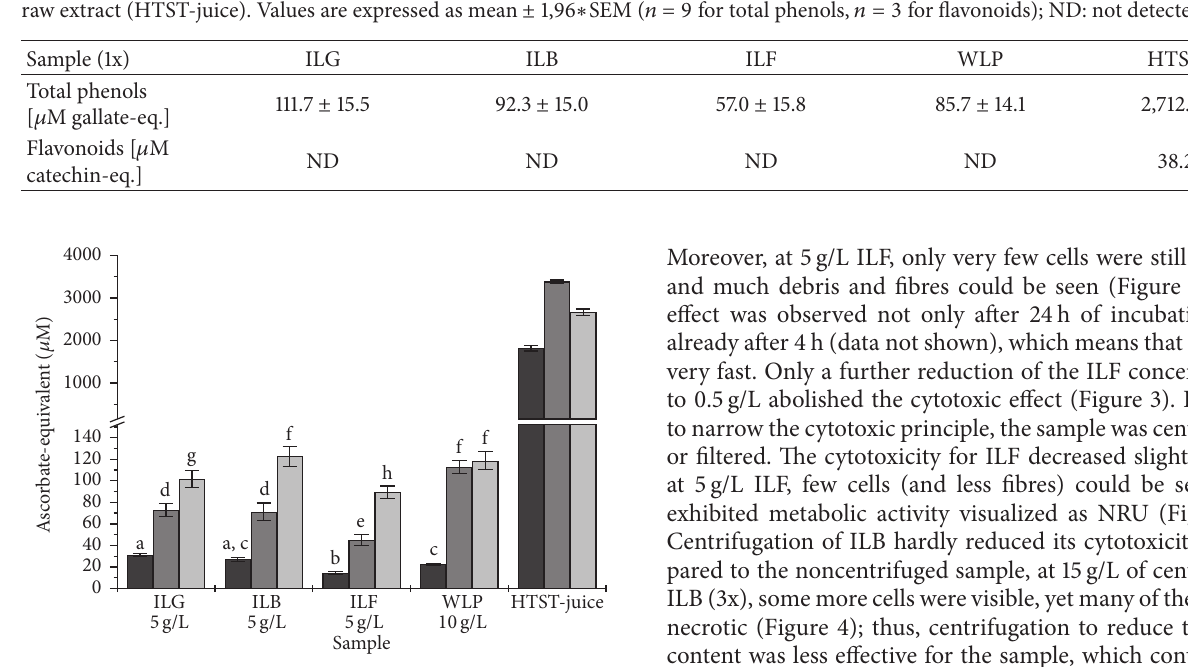
Figure 2: Antioxidant capacity of different starting products at the concentrations of 5g/L for ILG, ILB, and ILF and 10g/L for WLP (i.e., 1x) and HTST-juice measured as FRAP (dark grey), ABTS (grey), and DPPH (light grey). Values are expressed as mean ± 1,96 ∗ SEM ( 𝑛 = 7 –9). Letters indicate statistically significant